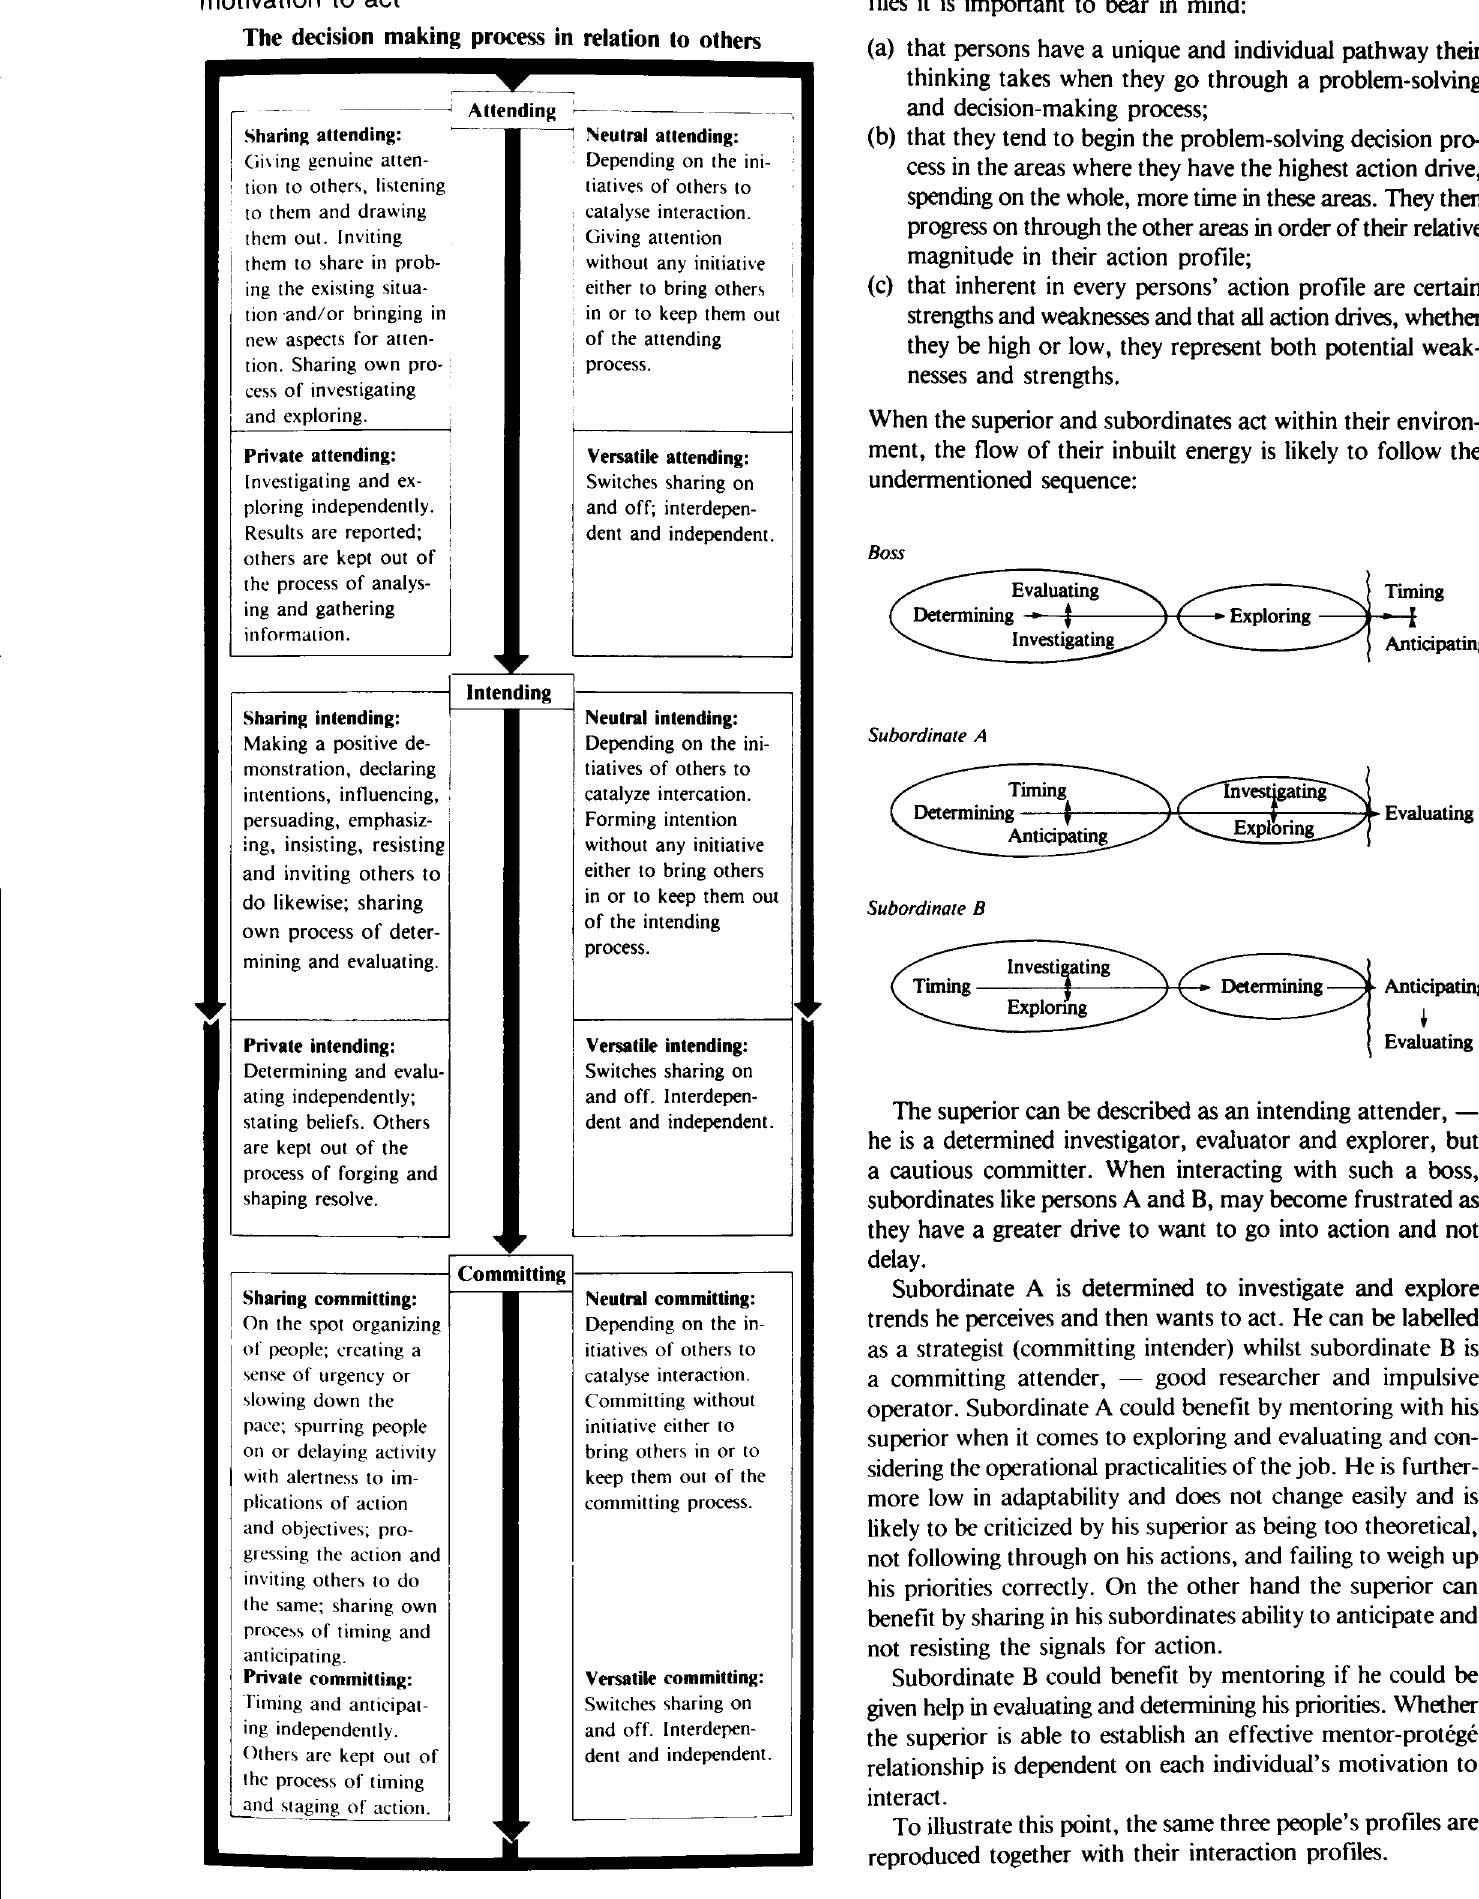
Table 5 Framework of management initiative: the motivation to act The decision making process in relation to